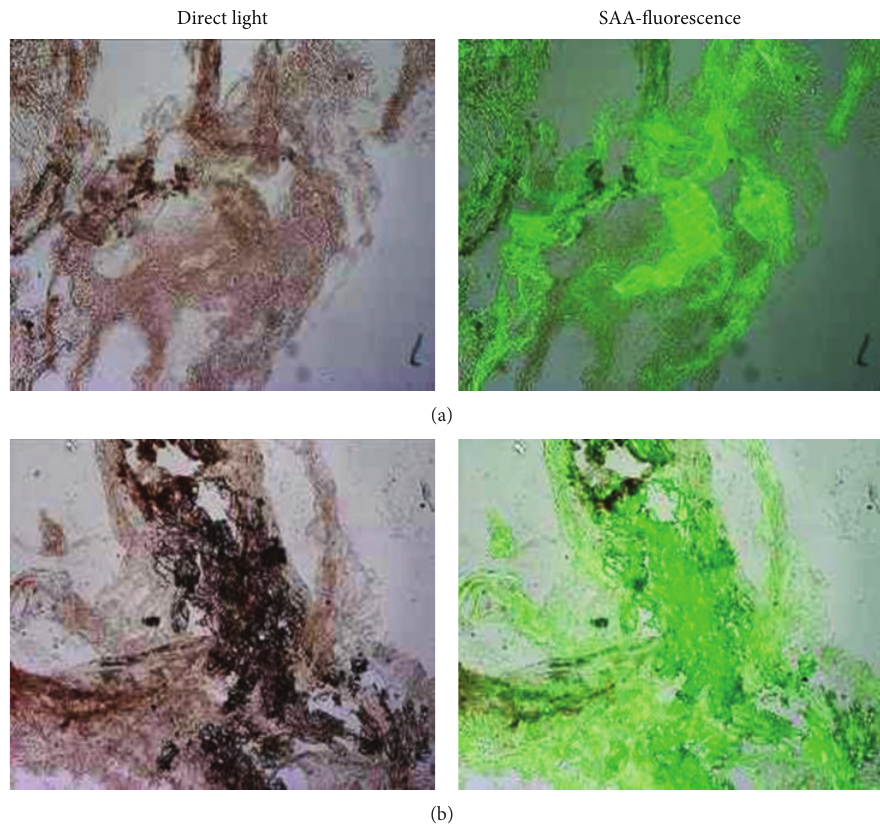
Figure 6: SAA detection in AKU aortic valve amyloid deposits. Positive staining for SAA-amyloid was particularly intense in correspondence of ochronotic pigmentation. SAA deposition in AKU aortic valve was detected by immunofluorescence technique. Magnification